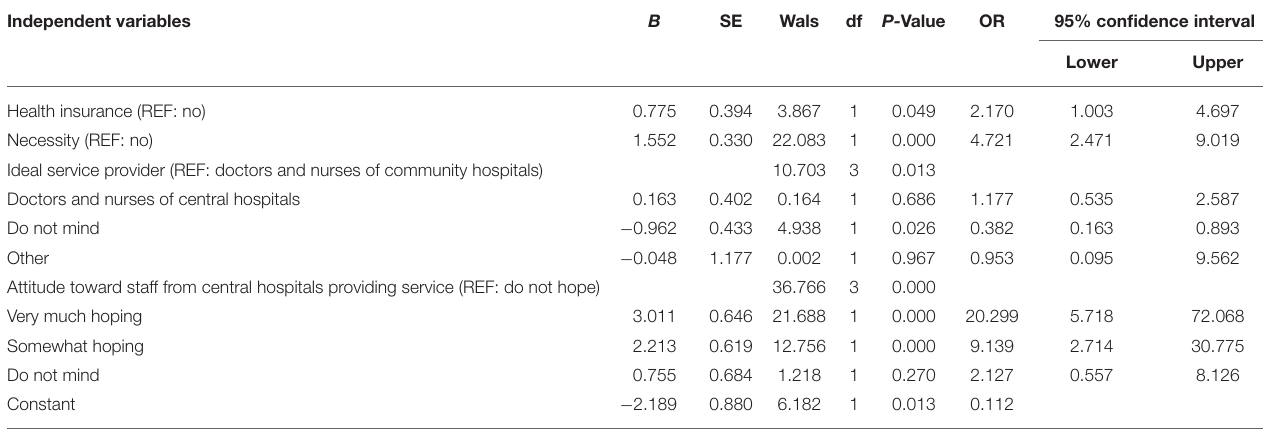
TABLE 4 | Comparison of the willingness to accept HaH services by predisposing variables, enabling variables, need factors, and HaH-related demands. Independent